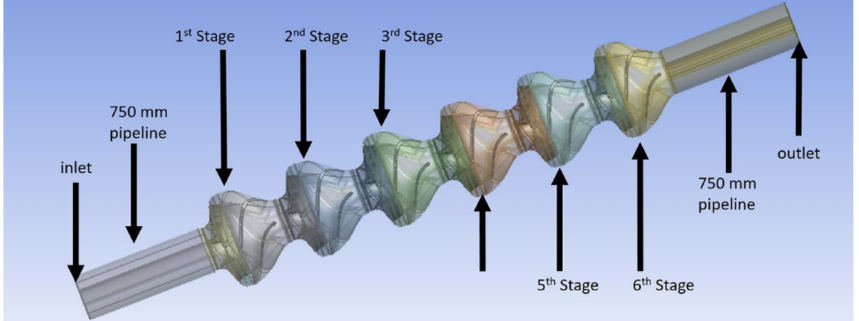
Figure 4. Computational domain of the six-stage centrifugal pump.